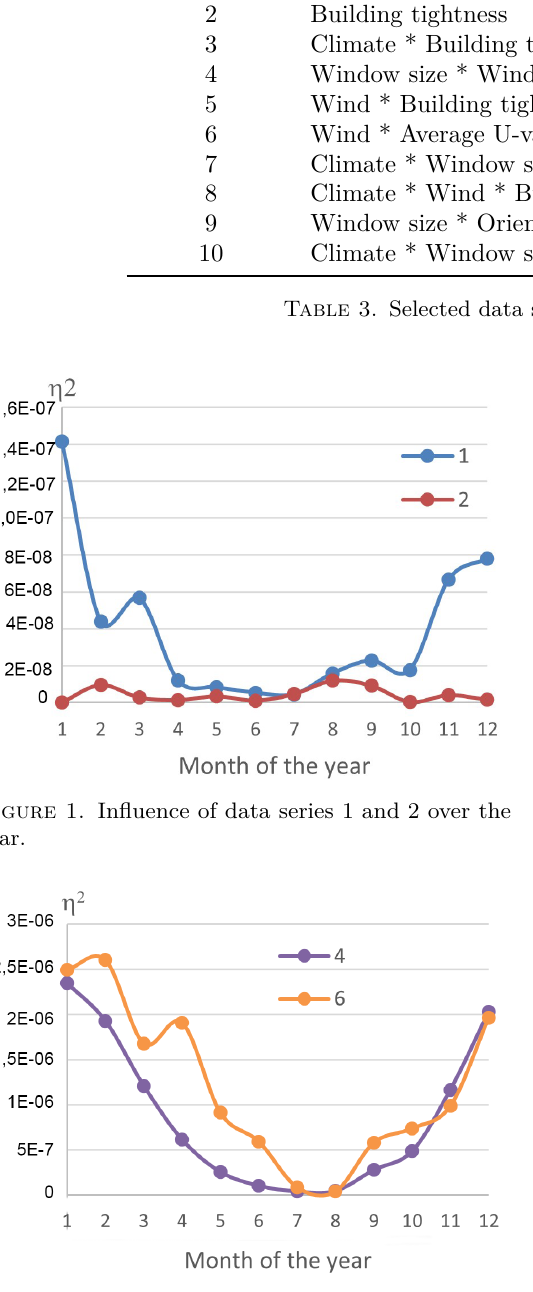
Figure 2. Influence of data series 4 and 6 over the year.